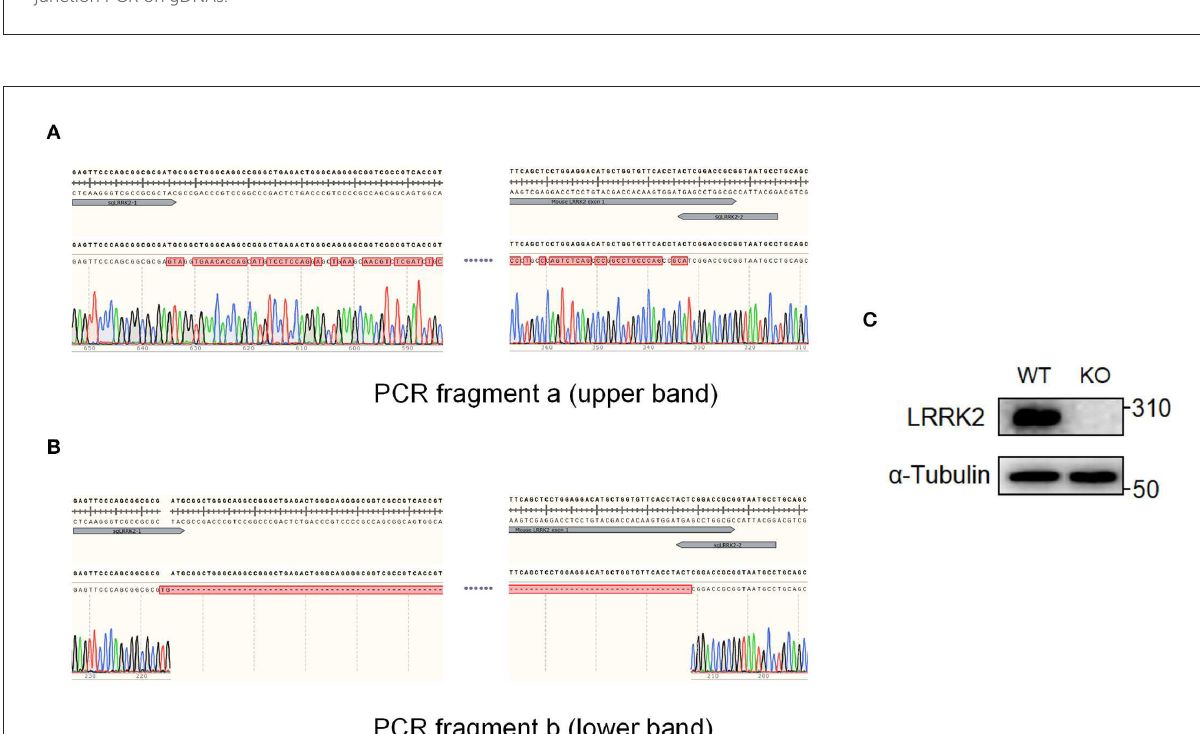
FIGURE3 Candidate knockout clones were validated by Sanger sequencing and Western blot. The two PCR fragments, a and b of single clone #7 in Figure 2B, were further sequenced, respectively. (A) Sequencing result revealed extensive nucleic changes between two sgRNAs, which has caused a frameshift of LRRK2 ORF and finally led to premature stop of translation. (B) Sequencing of PCR fragment b showed that the genomic region, harboring 5’UTR and exon 1 of LRRK2 between two sgRNAs, has been successfully cleaved. (C) LRRK2 protein expression was verified by Western